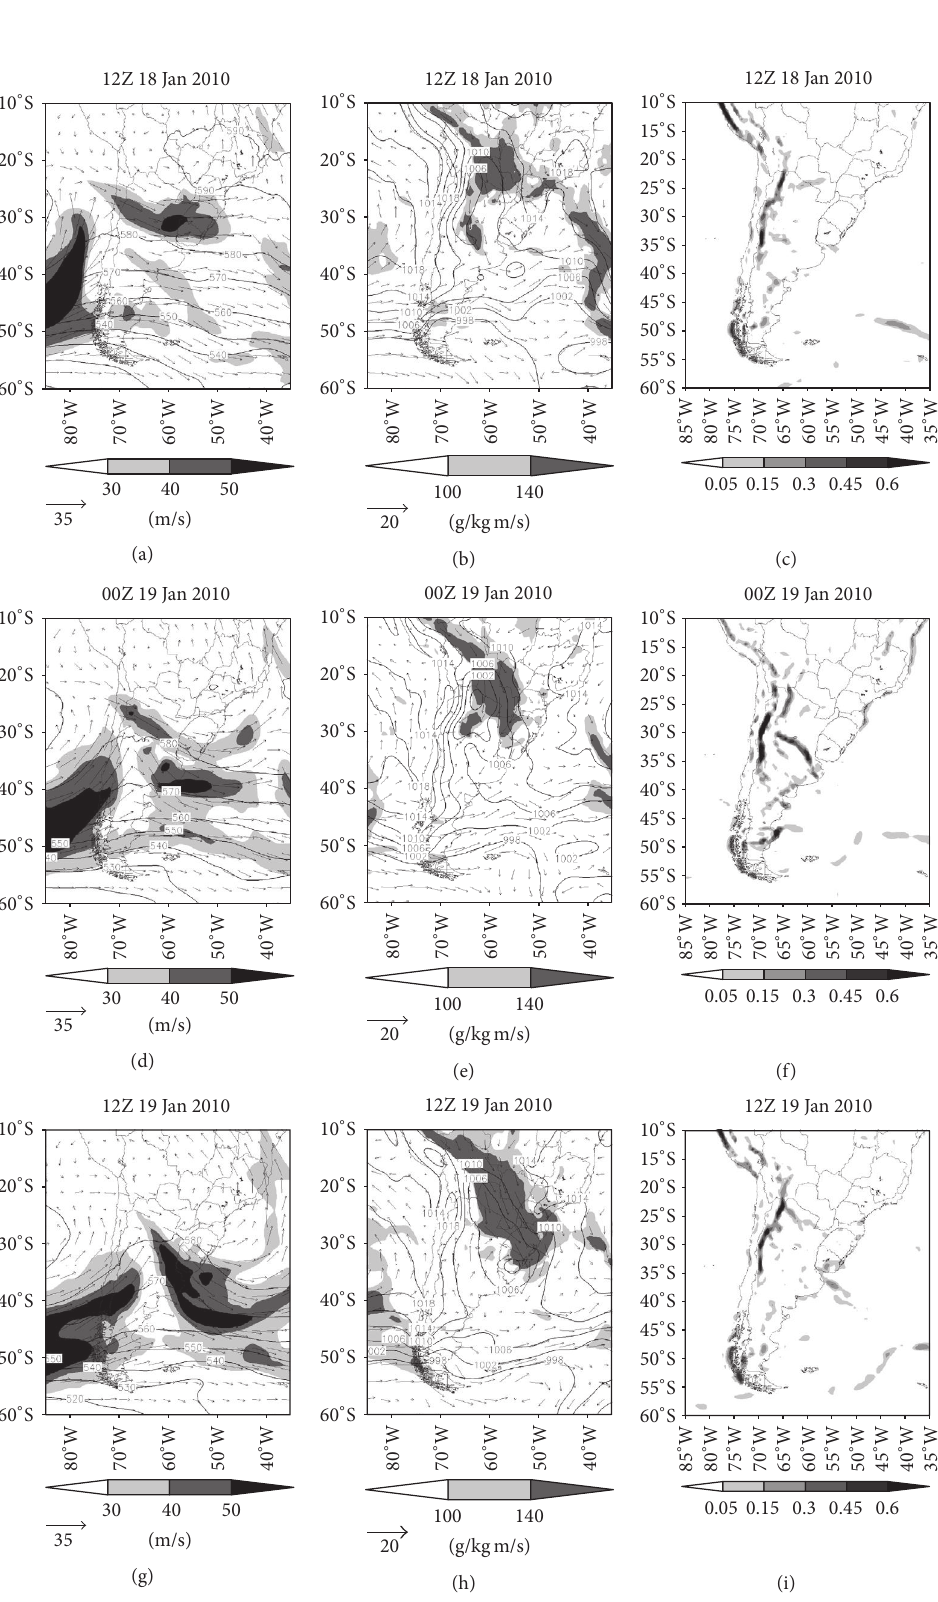
Figure 5: Same as in Figure 4 but valid at 12Z 18 January 2010 ((a)–(c)), 00Z 19 January 2010 ((d)–(f)), and 12Z 19 January 2010